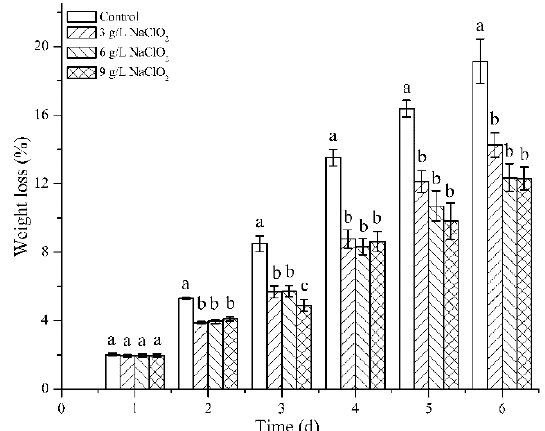
Figure 4. Weight loss of strawberries packed in different corrugated cardboard boxes during storage at room temperature. Means of differenct samples with different letters (a, b, c) on the same day of storage were significantly different ( P > 0.05).